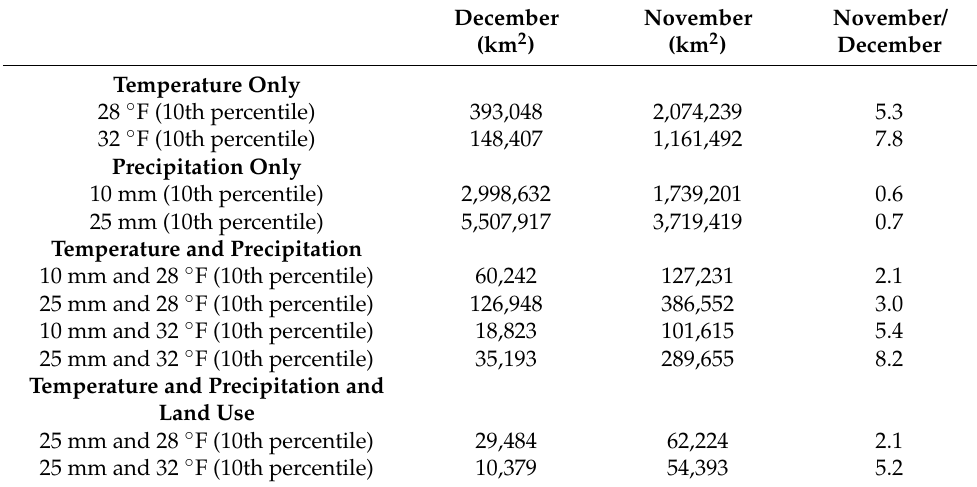
Table 2. Summary of all analyses presented in Figures 2 – 9. Results show the area in km 2 of the continental United States that meet the temperature, precipitation, or land use criteria (note: 32 °F = 0 °C, 28 °F = −2. 2 °C).